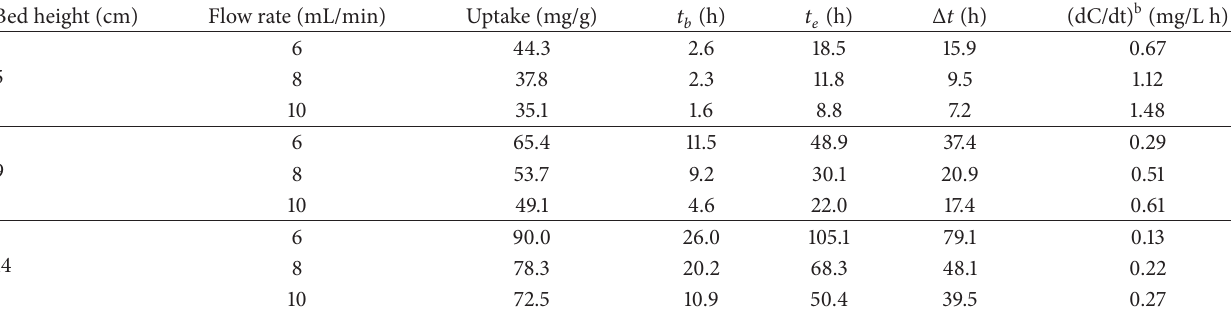
Table 2: Column data and parameters obtained for poly(EGDMA-VIM).